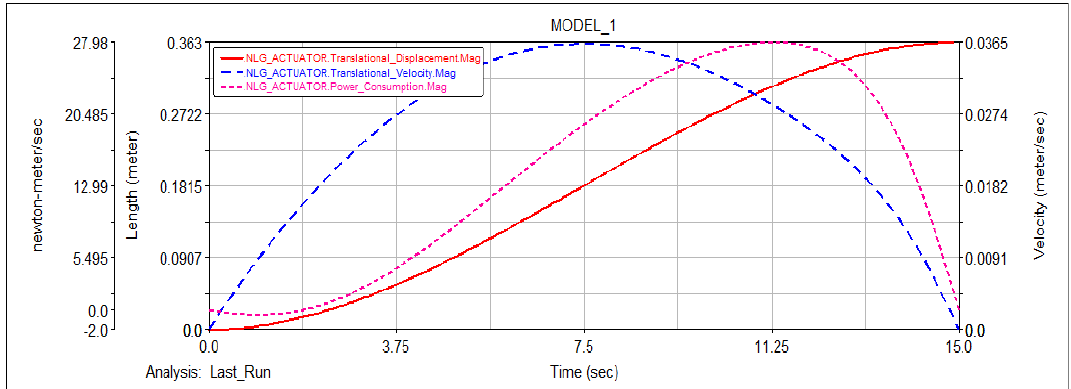
Figure 8. Computational evaluation of Stroke, Velocity and Power with time. Maximum velocity of 3 cm/s was achieved in the middle of retraction cycle after 7.5 s.